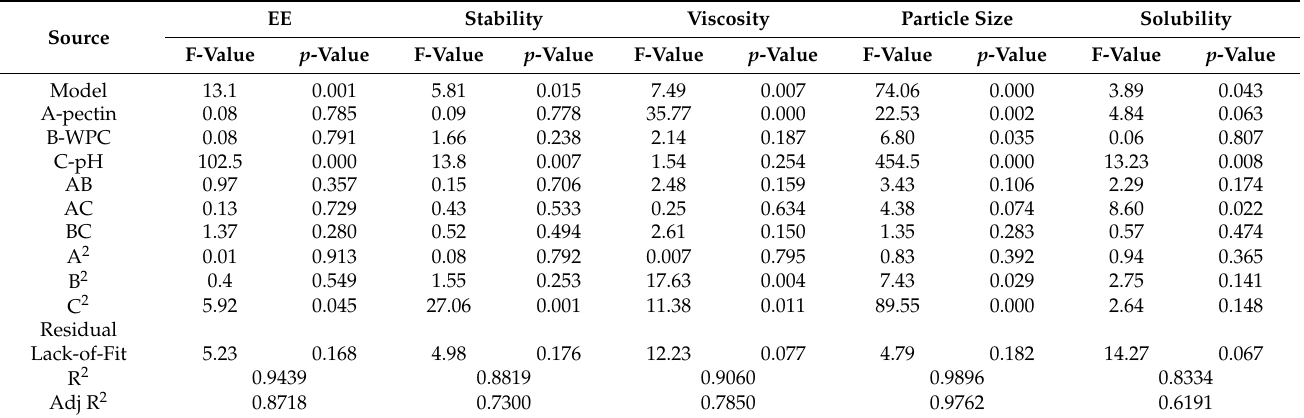
Table 1. The results of ANOVA for properties of complex carriers loaded with vitamin B 12 .